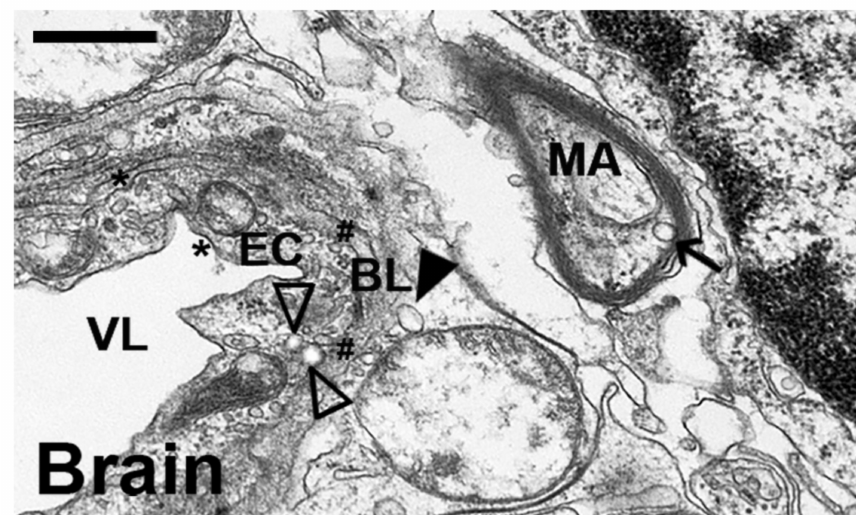
Figure 7. Visualization of coated anti-ICAM/ASM PLGA NPs in mouse brain. Wildtype C57B/6 mice were i.v.-injected similarly to those in Figure 6, followed by isolation of brain samples 3 h af- ter NP administration and processing for transmission electron microscopy. BL = basal lamina; EC = endothelial cell; MA = myelinated axon; VL = (blood) vessel lumen. Open arrowheads = NPs close to the abluminal side of an endothelial cell; closed arrowheads = NP located passed the en- dothelium and basal lamina; arrow = NP within the myelinated axon of a neuron. * = clathrin-coated pits. # = caveolae-like vesicles. Scale bar = 500